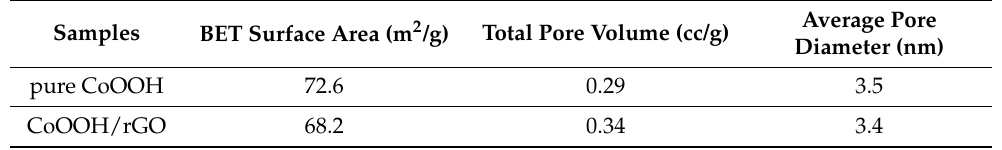
Table 1. The surface properties of pure CoOOH and CoOOH/rGO. Samples BET Surface Area (m 2